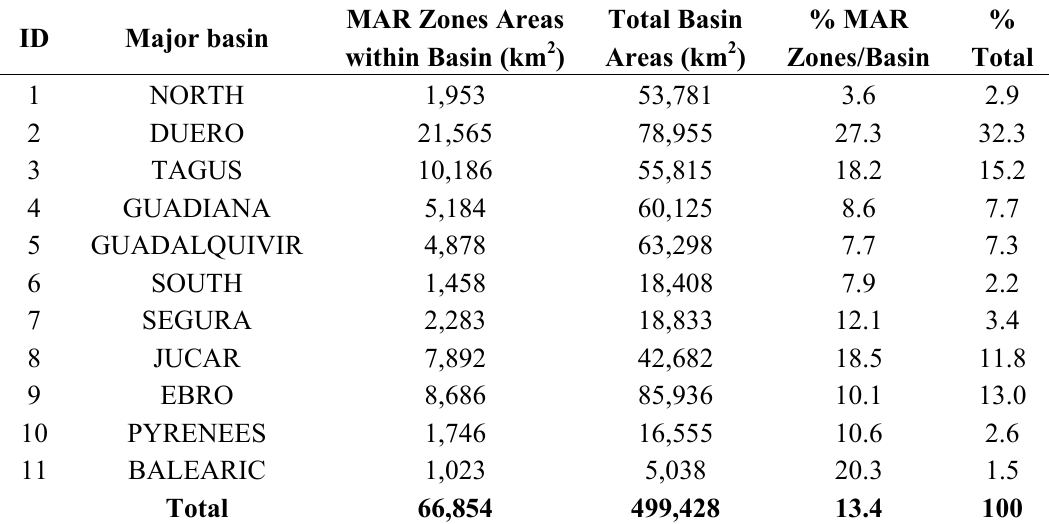
Table 1. Relating “Managed Aquifer Recharge (MAR) zones” by hydrographic major basins. Columns: basin name, the MAR zone area contained in the basin, the basin area, the percentage of the basin covered by a MAR zone and the percentage of an individual MAR of the total MAR